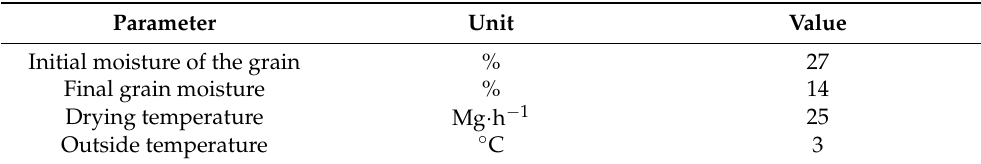
Table 4. Working conditions of the DT2532 dryer during testing.